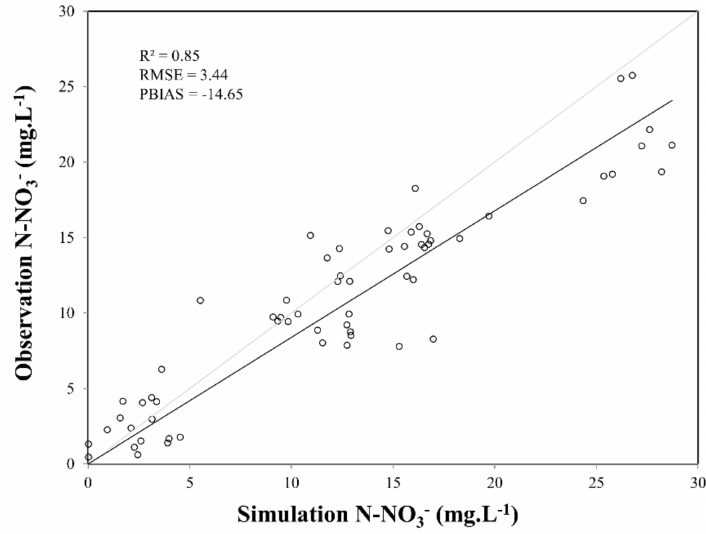
Figure 6. Observed and simulated (dilution plus denitrification) groundwater nitrate concentration in